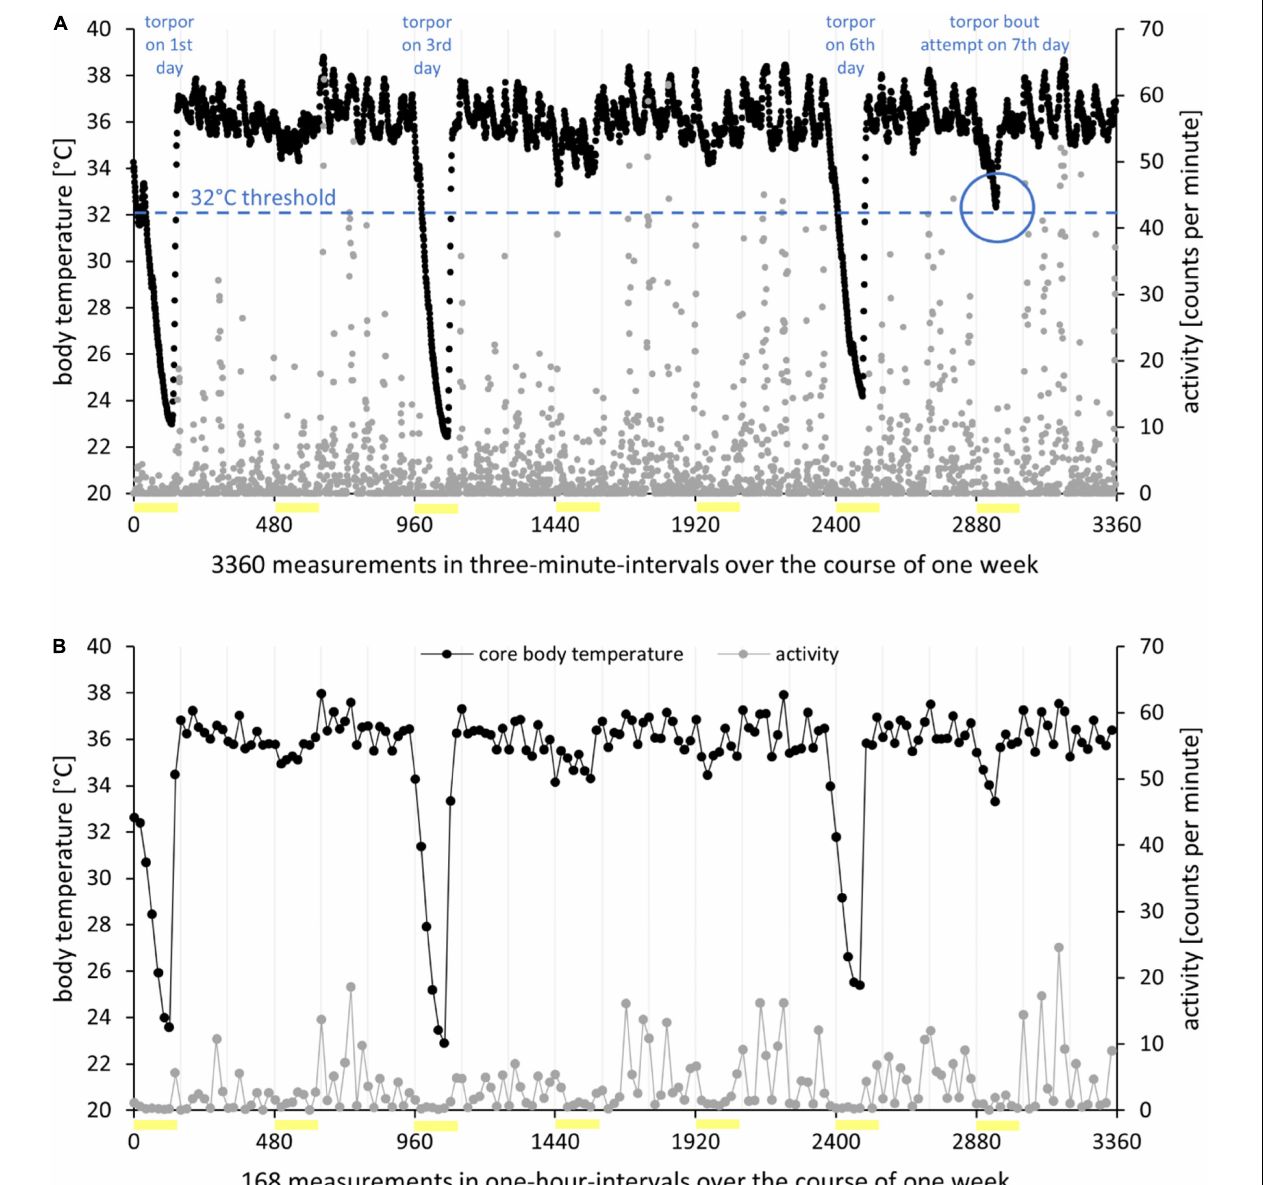
FIGURE 1 | Processing of radiotelemetry data I. Body temperature (in degree Celsius, black ) and activity (in counts per minute, gray ) of hamster EH02-27 over the course of 1 week in the short photoperiod (L/D 8:16 h). Photophases are indicated as yellow bars . (A) High resolution. Real-time raw data recorded in 3-min intervals. Within the 7 days, the hamster expressed three torpor bouts per definition with body temperature below 32 ◦ C for at least 30 min, resulting in a torpor incidence of 0.43. On the last day of the analysis week, the hamster showed a torpor bout attempt. While the body temperature hardly changed from one measurement to the next, the activity data were highly variable. (B) Low resolution. Processing of raw data to mean values per hour resulted in a smoothing of the body temperature measurements; however, the activity data became more